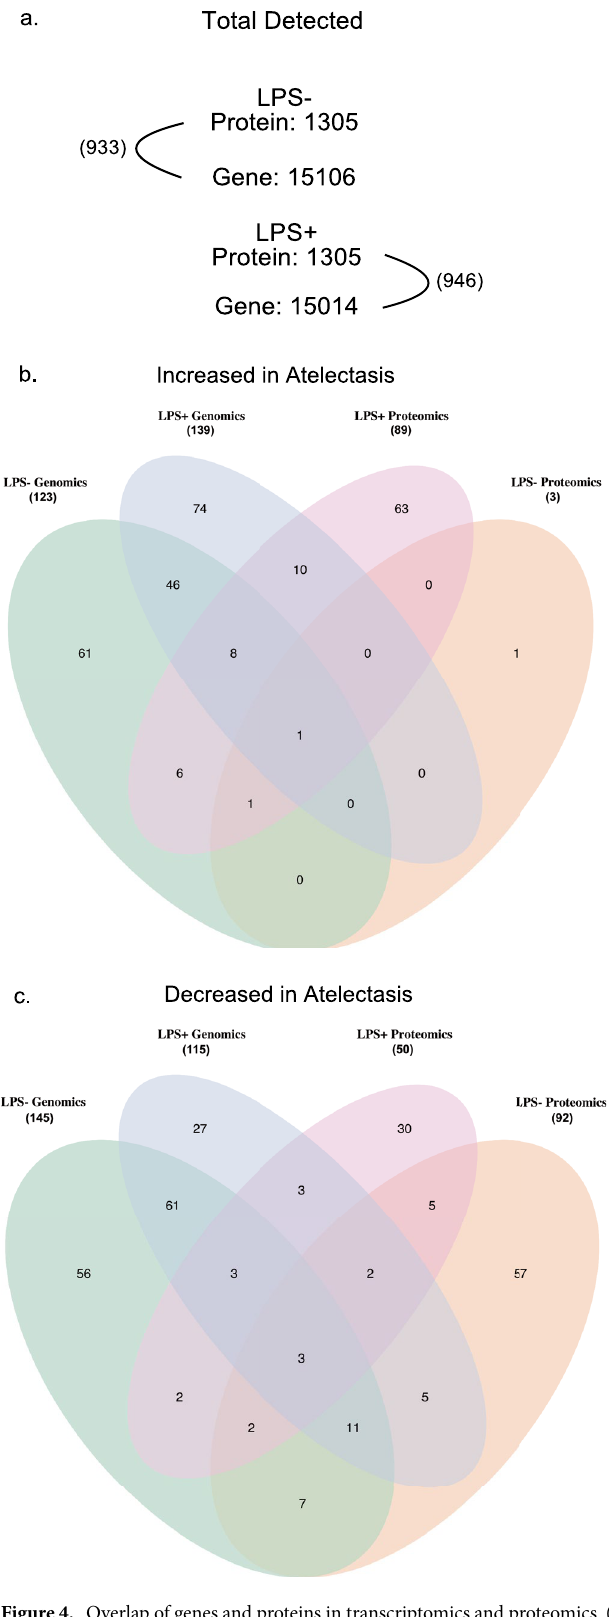
Figure 4. Overlap of genes and proteins in transcriptomics and proteomics. ( a ) The numbers of total detected proteins and genes in LPS(−) or LPS(+) conditions and the numbers in parentheses indicating the possible overlap between proteomics and transcriptomics. ( b , c ) Venn diagram showing the overlap of significantly increased ( b ) or decreased ( c ) gene/protein pairs in atelectatic relative to aerated lung in both transcriptomics and proteomics. In parenthesis, the total significant genes or proteins detected based on directionality of magnitude (increased or decreased) are displayed. LPS